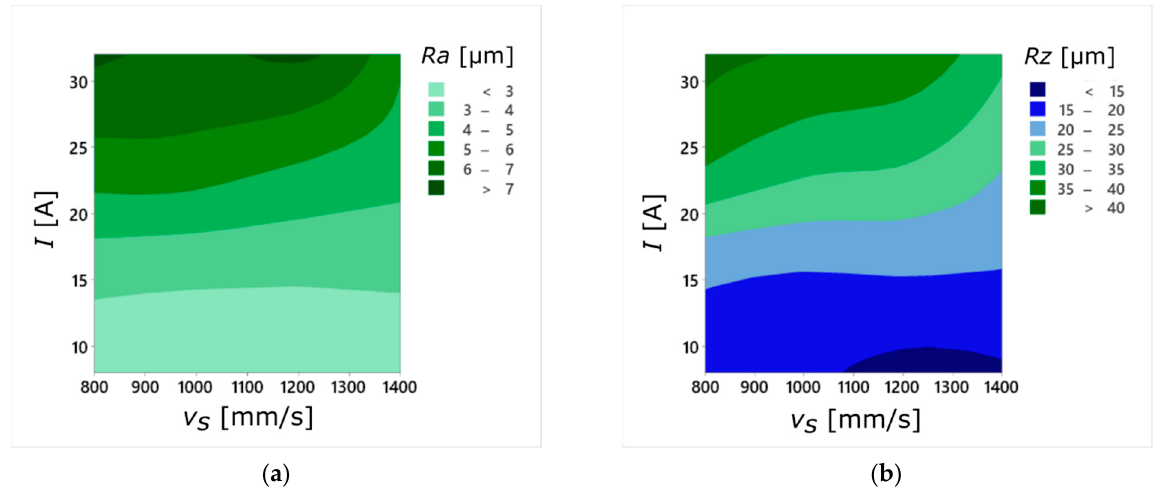
Figure 7. Relationship between the current amplitude ( I ) and the laser scanning speed ( v s ) and the average values of surface roughness parameters: ( a ) Ra ; ( b ) Rz